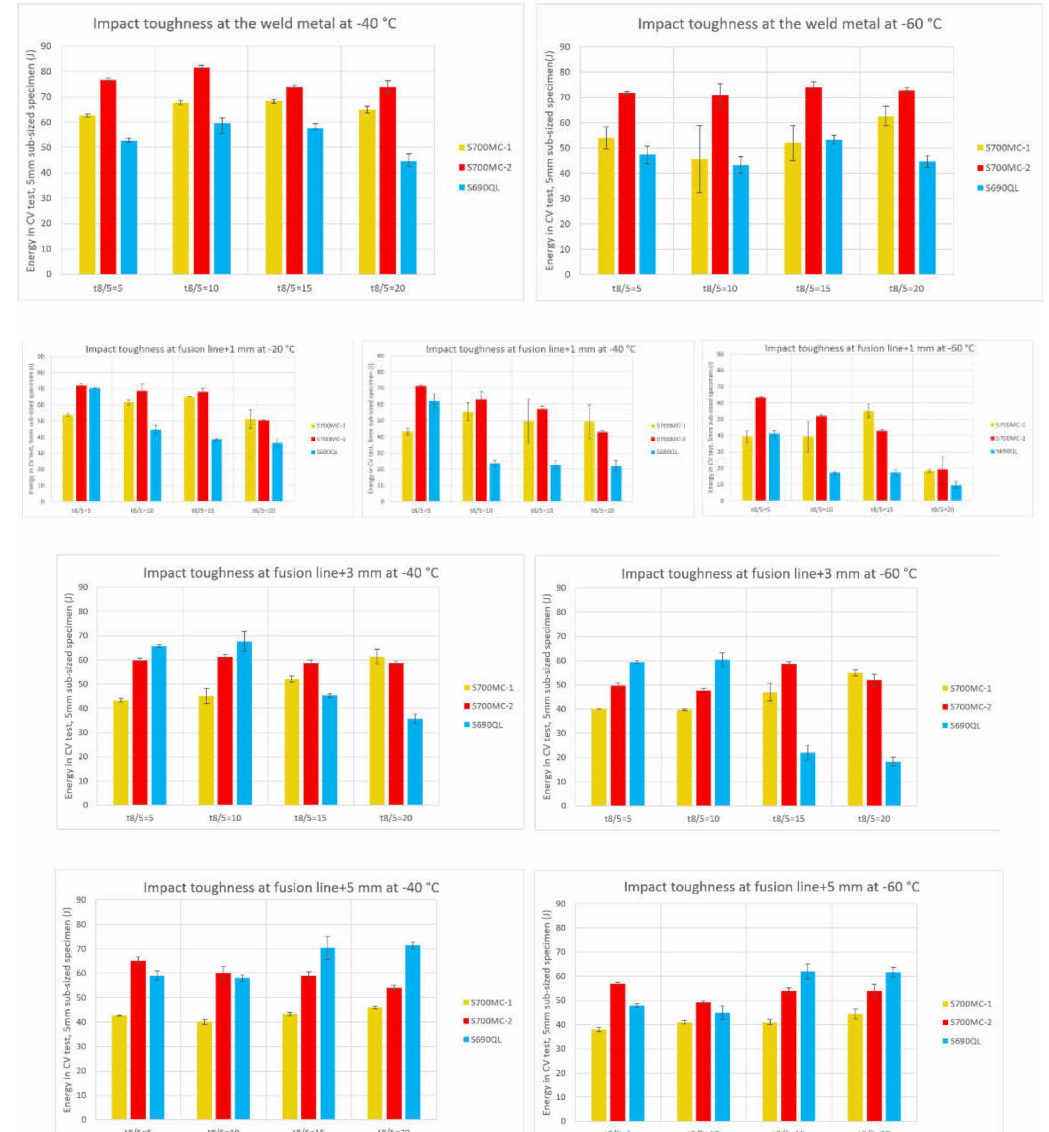
Figure 11. Charpy-V impact toughness results for all the welds. Specimens having the notch at FL + 1 mm were tested at − 20, − 40 and − 60 ◦ C. Specimens having the notch at WM, FL + 3 mm and FL + 5 mm were tested only at − 40 and − 60 ◦